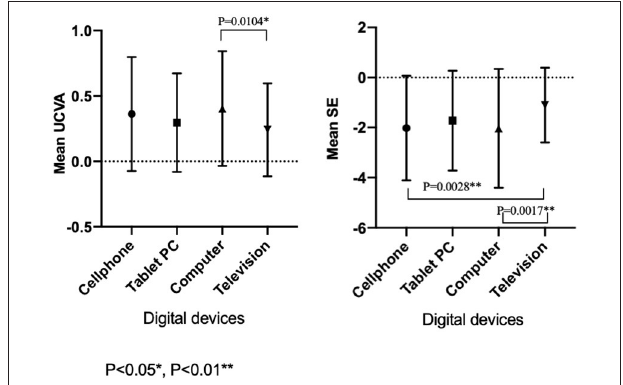
FIGURE 3 | The mean uncorrected visual acuity and spherical equivalent refraction with different digital devices used for education in 2020.